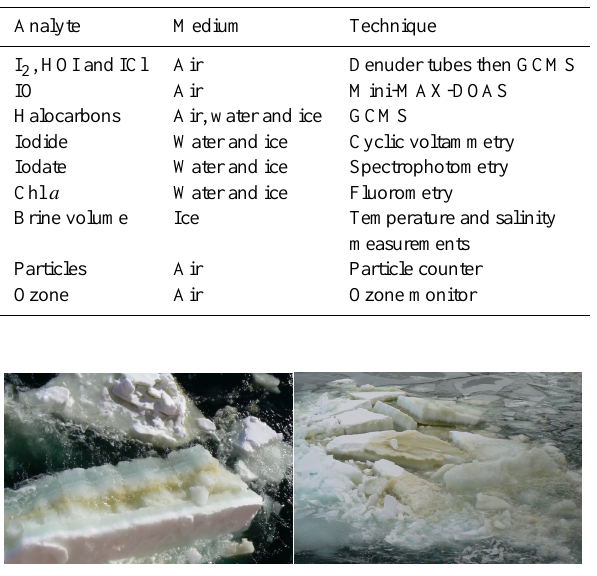
Fig. 2. Ice floes broken by the ship’s passage through sea ice of thickness 0.2 m in the Weddell Sea, where diatom bands are clearly visible about 0.1 m below the surface of the ice.